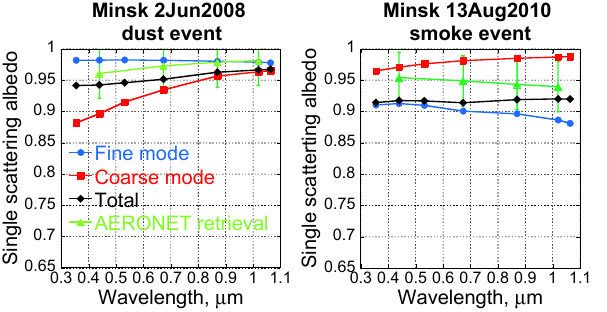
Fig. 18. Retrieved aerosol single-scattering albedo.